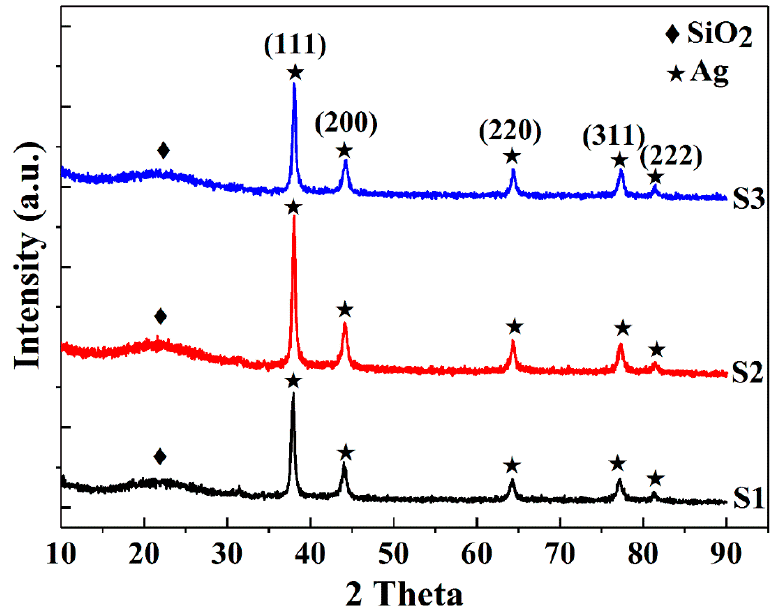
Figure 1. XRD patterns of S1, S2 and S3 samples.